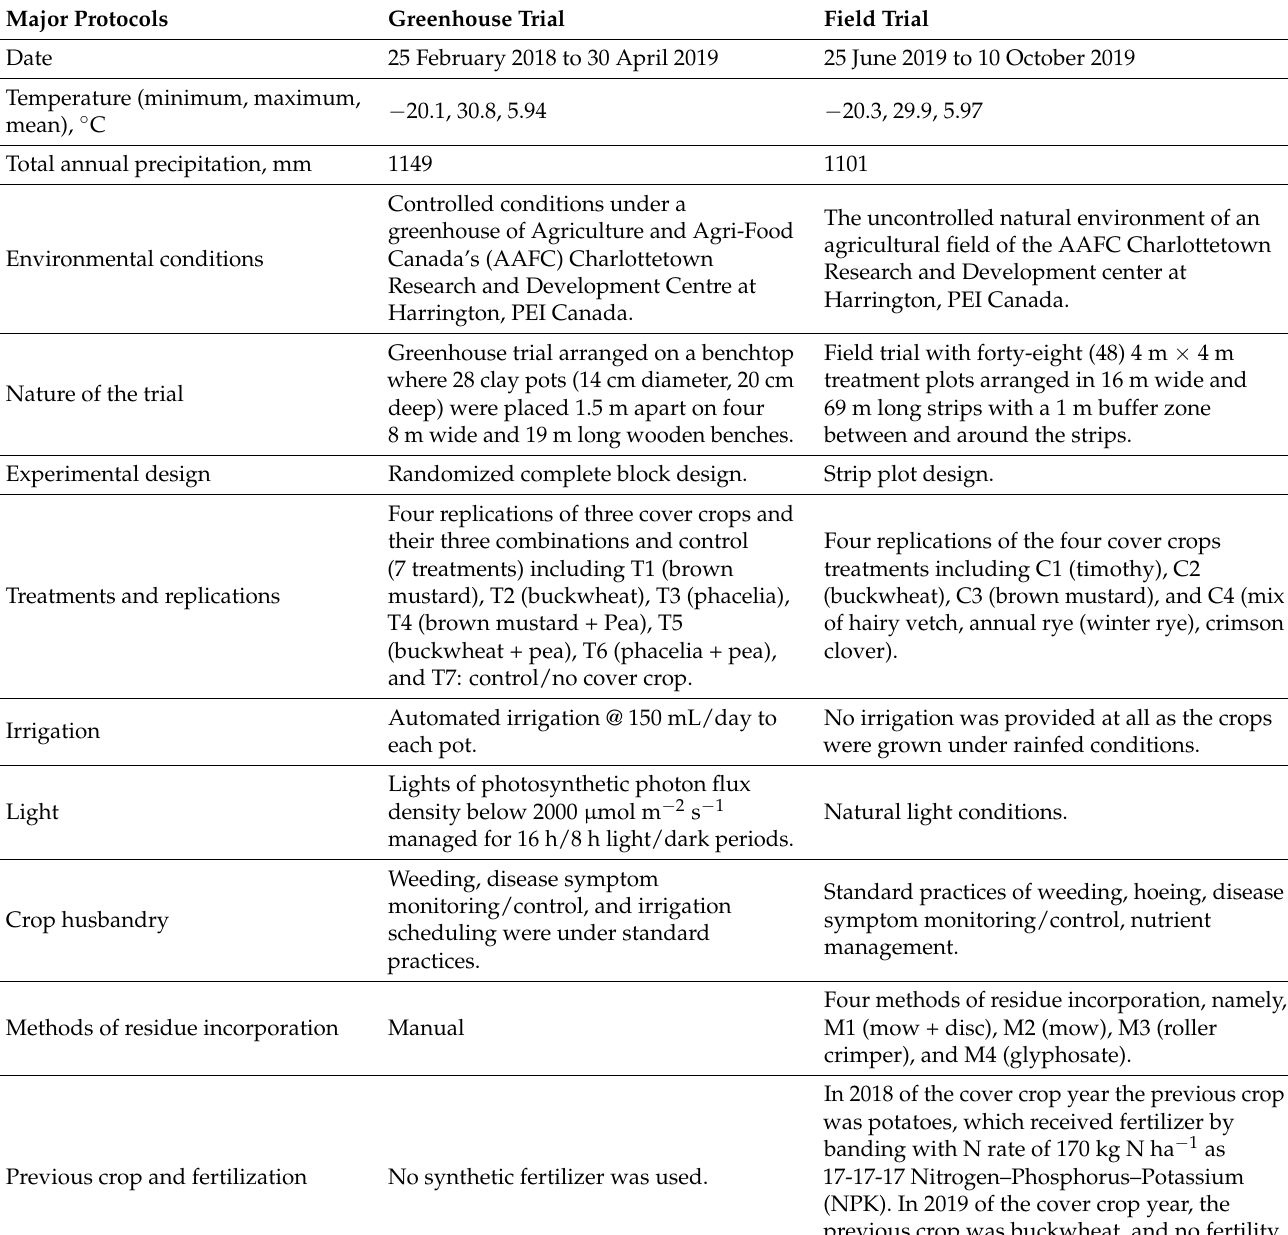
Table 1. Information about the greenhouse and field